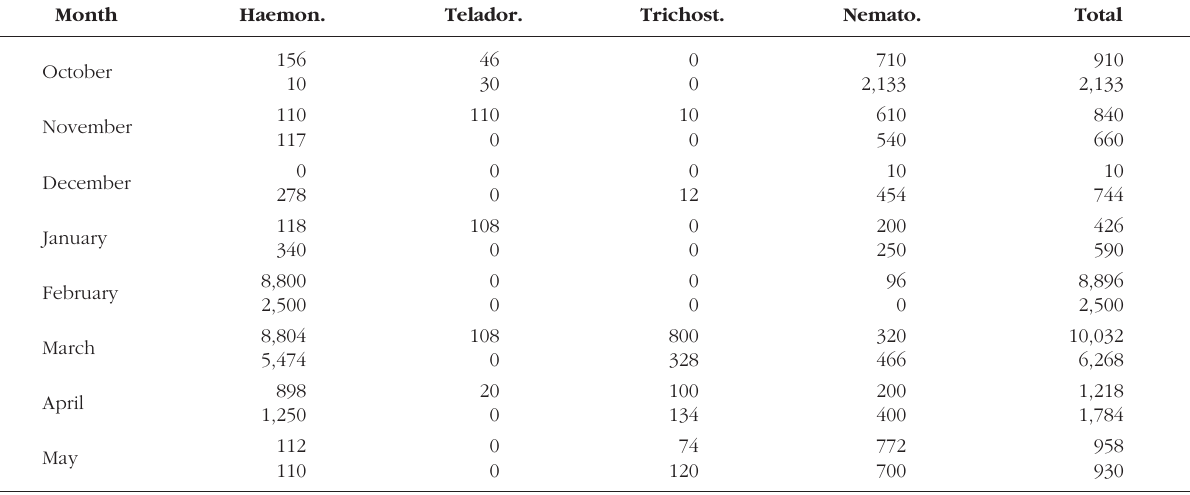
Table I. - Total number of gastrointestinal nematodes recovered from tracer lambs.